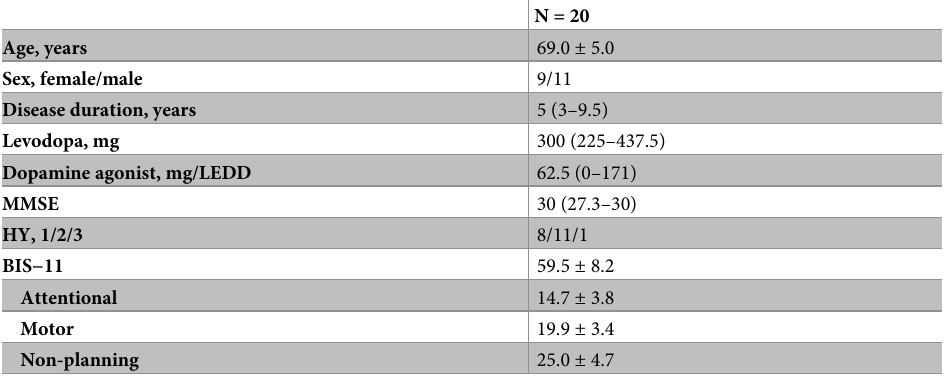
Table 1. Demographic and clinical parameters of patients with Parkinson’s